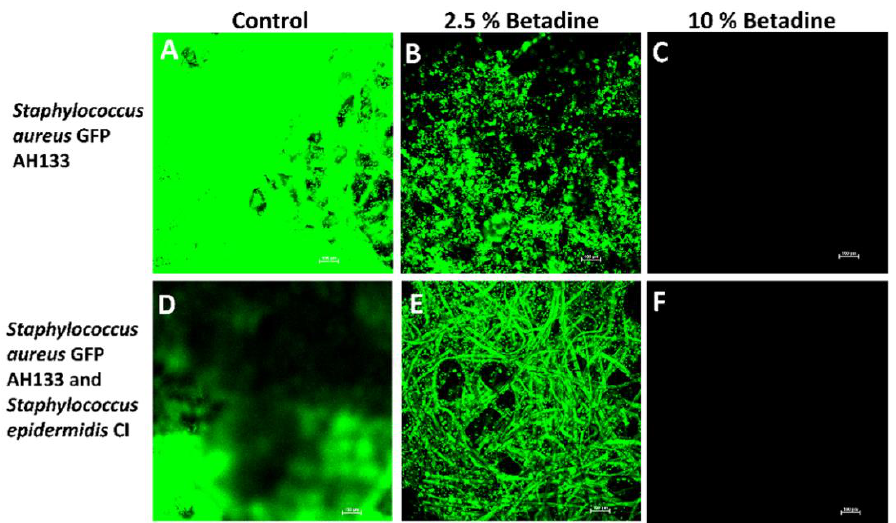
Figure 3. Confocal laser scanning microscopy of the S. aureus GFP AH133 grown alone ( A – C ) and S. aureus GFP AH133 and S. epidermidis CI grown together ( D – F ) that remained on the disc after treatment.